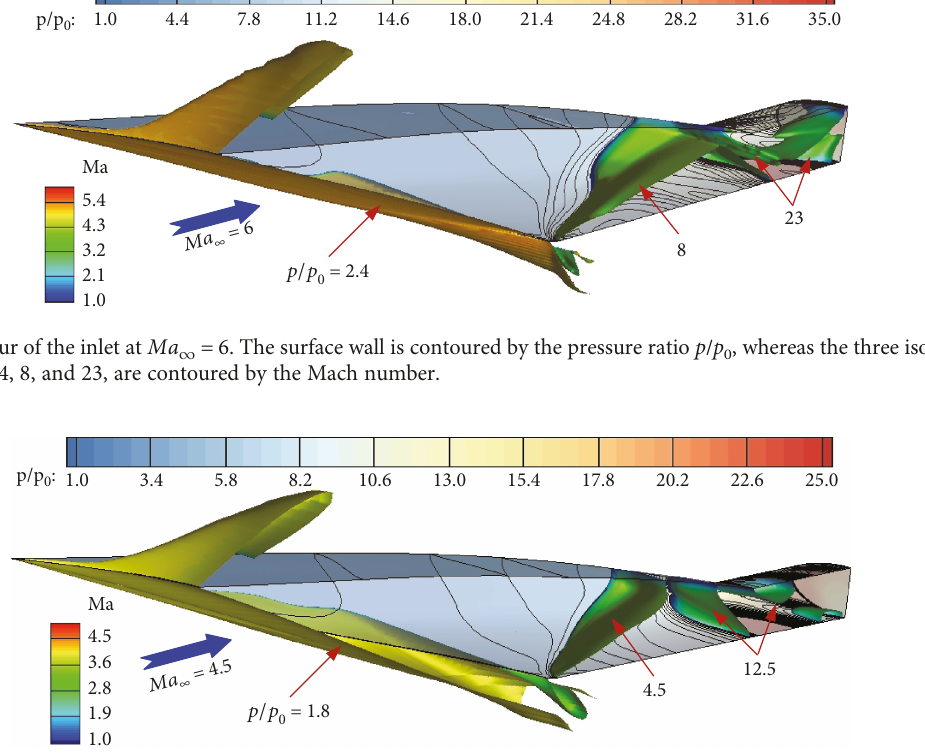
, whereas the three isobaric surfaces, 0